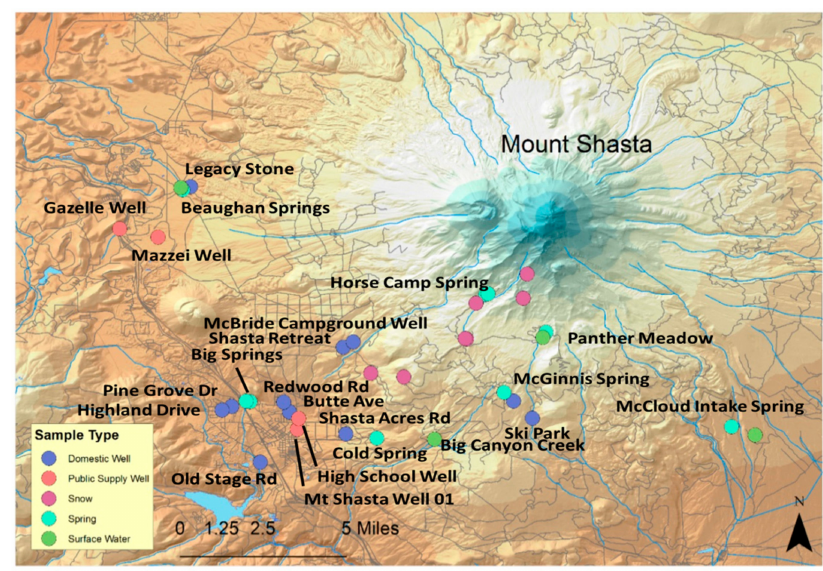
Figure 1. Location and type of water samples collected in May and September 2015 and of snow samples collected in February